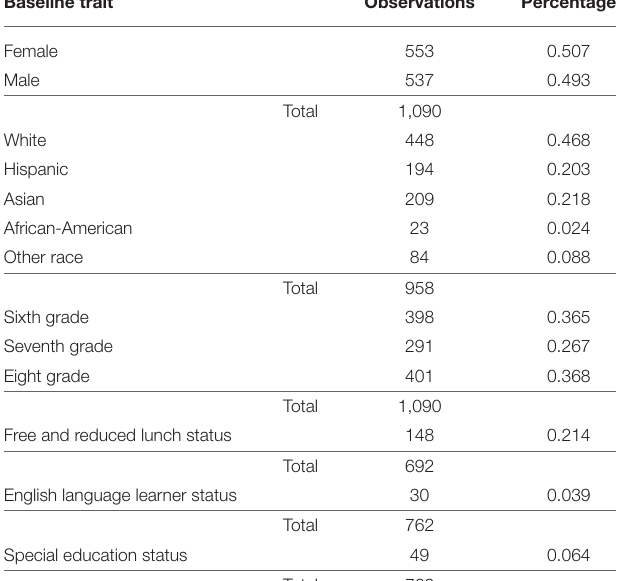
TABLE 2 | Baseline traits description. Baseline